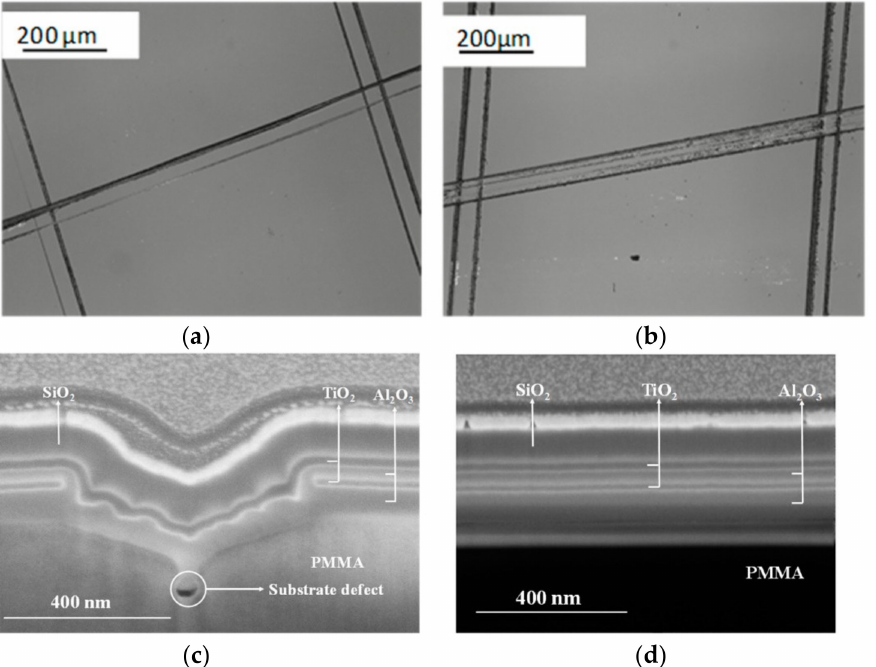
Figure 18. Schematic representation of one cycle of Al 2 O 3 by thermal ALD and plasma ALD techniques. In plasma ALD, the H 2 O co-reactant is replaced with a plasma exposure (e.g., O 2 plasma) to grow metal oxides. ( a ) Optical microscopic images after cross-hatch tests and ( b ) after climate test of antireflection coatings double-sided coated PMMA. Focused ion beam scanning electron microscopy (FIB-SEM) cross-sectional image of multilayered antireflection coatings on PMMA ( c